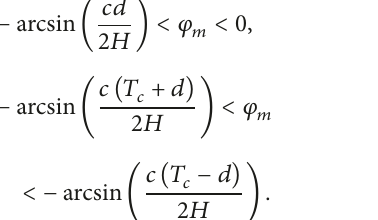
( sin 2 ((𝜃 − 𝜑 𝑚 { arg ( sin 2 ((𝜃 − 𝜑 𝜃 𝜑 𝑚